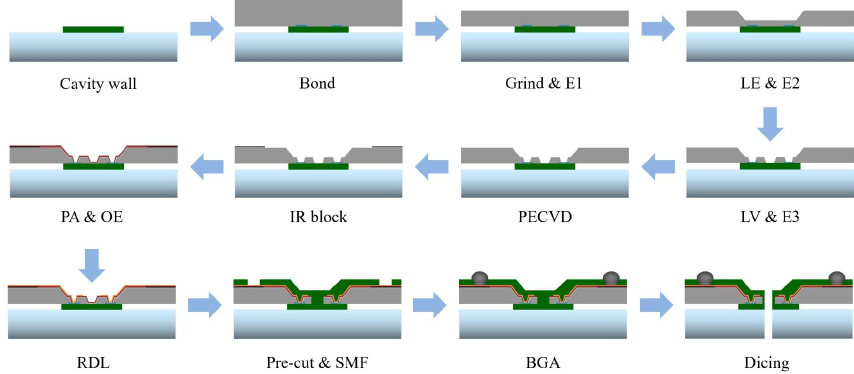
Figure 3. The schematic of CIS-WLCSP process flow.